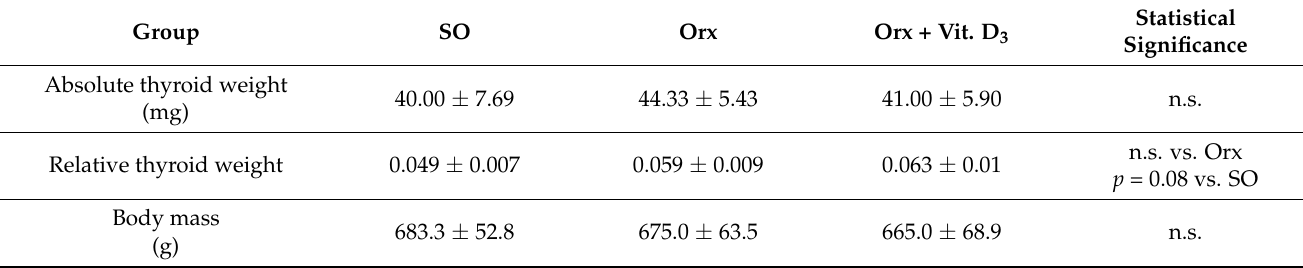
Table 2. Absolute and relative thyroid weight, body